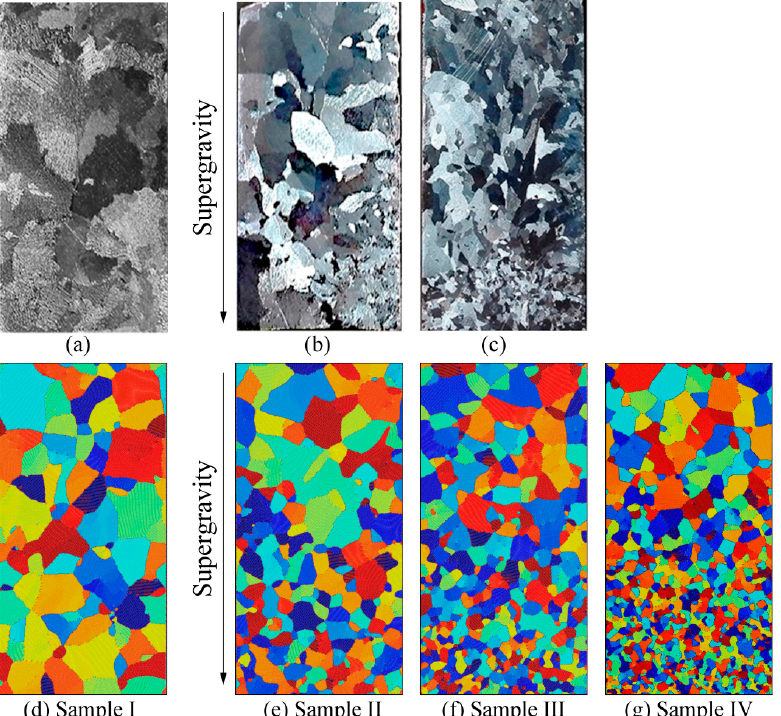
Figure 10. The experimental microstructure of the Al-4.5 wt % Cu melt solidified under normal-gravity ( a ), 100-times normal-gravity ( b ), and 500-times normal-gravity fields ( c ) [13]. The solidification structures of the four samples simulated in this work are shown in ( d – g ), where ( d ) is the solidification structure in the zero-gravity field, and ( e – g ) are the solidification structures in the increasing strength of the supergravity field. Different colors correspond to grains with different orientations.